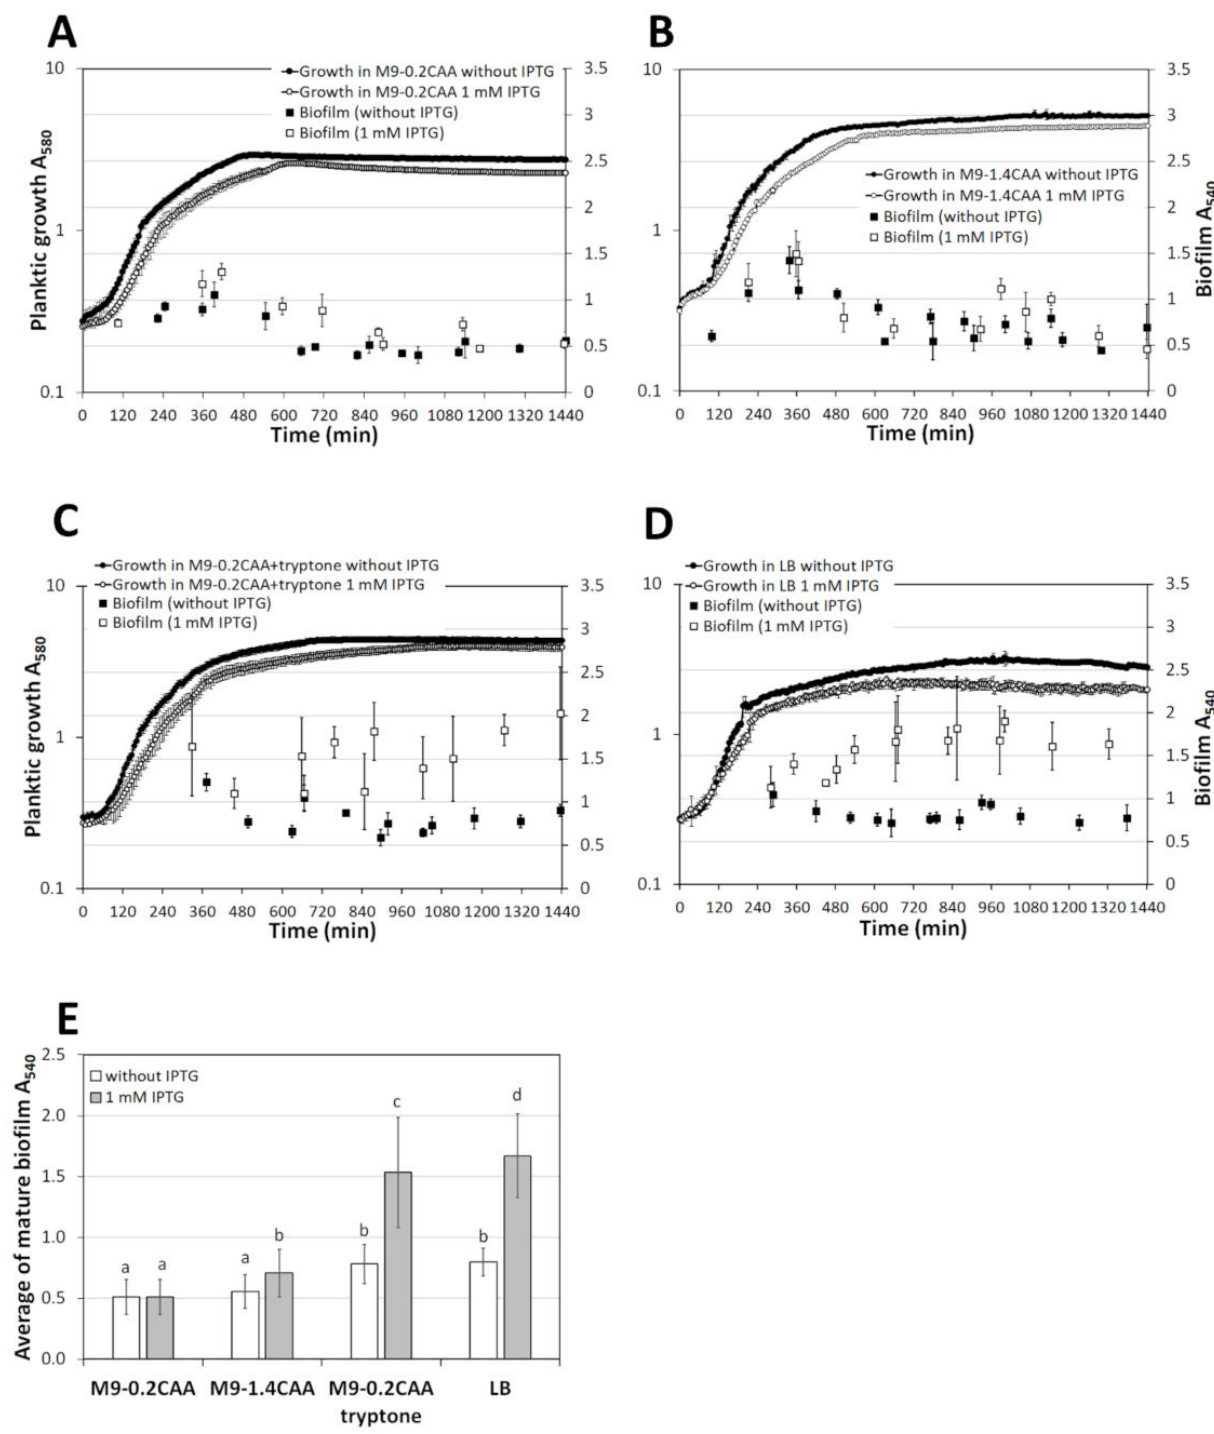
Figure 6. The biofilm dynamics and growth curves of P. putida fis -overexpression strain F15 grown in ( A ) M9-0.2CAA, ( B ) M9-1.4CAA, ( C ) M9-0.2CAA+tryptone, and ( D ) LB media in the presence or absence of 1 mM IPTG. ( E ) The average mature biofilm of PSm was calculated from timepoints 8 to 24 h. The arithmetical averages are shown. Brackets show the 95% confidence intervals, and the homogenous groups are shown above columns by the lower-case letters. Identical letters denote non-significant differences ( p ≥ 0.05) between averages of